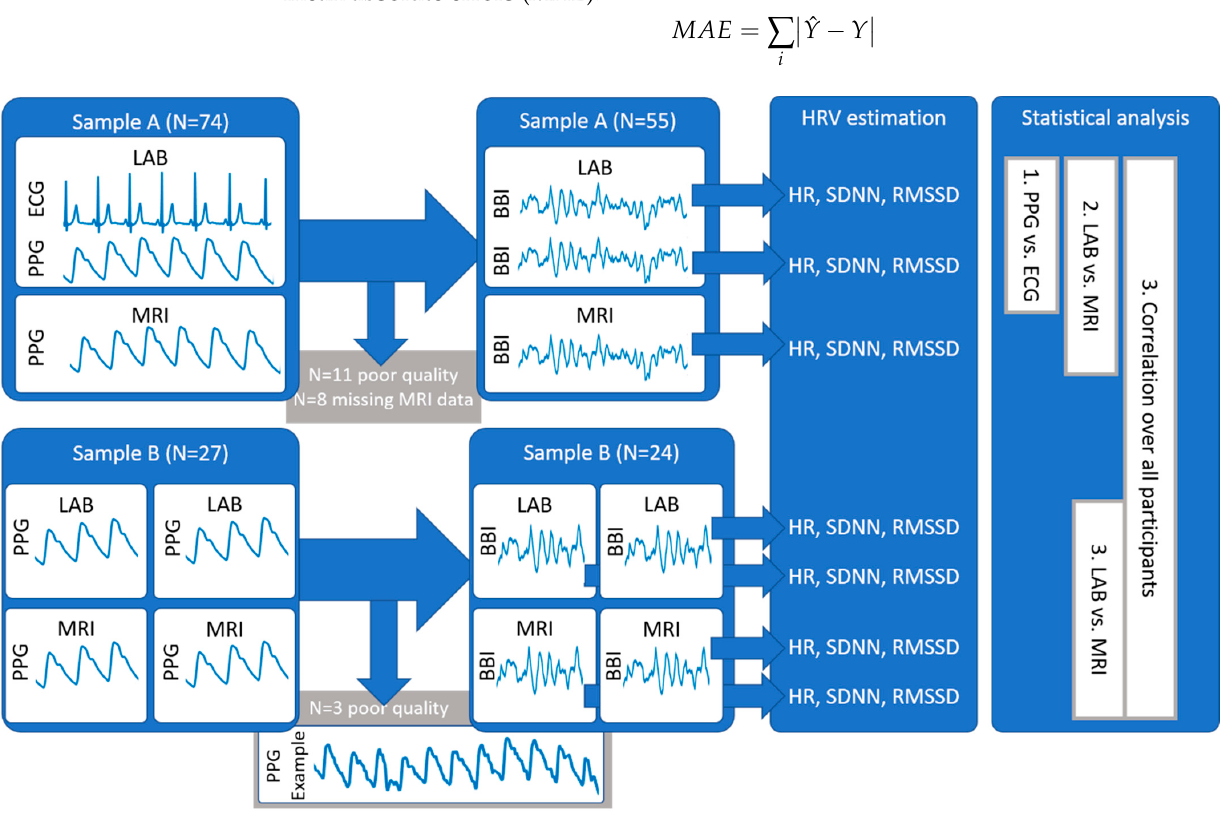
Figure 1. Schematic illustration of the workflow in this study.